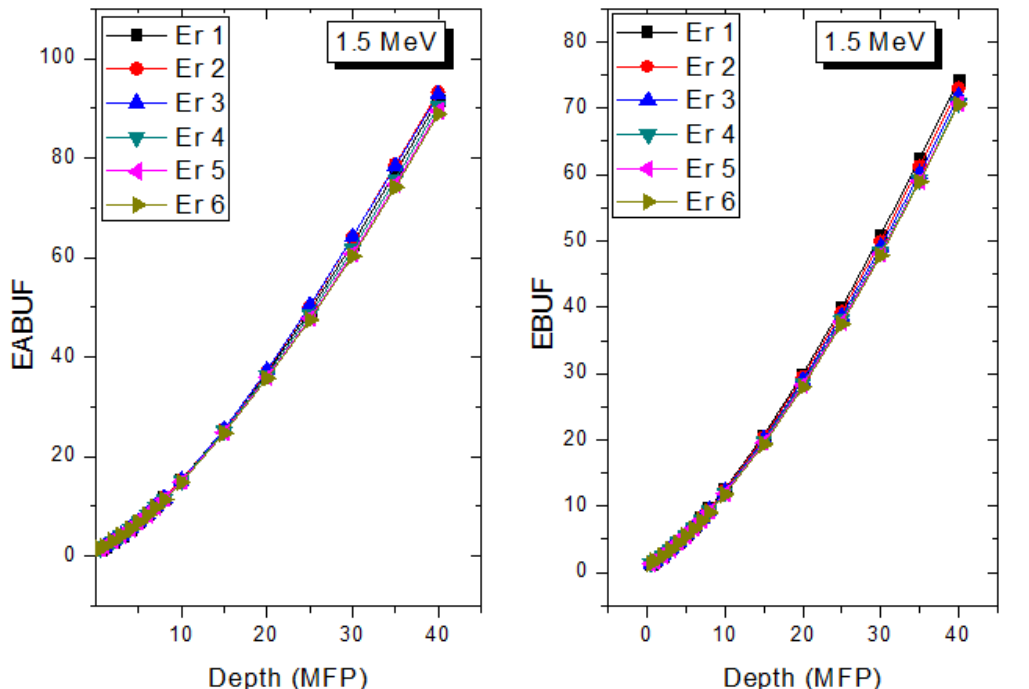
Figure 9. Effect of chemical composition on EABUF and EBUF at different depth for 1.5 MeV photon energy.